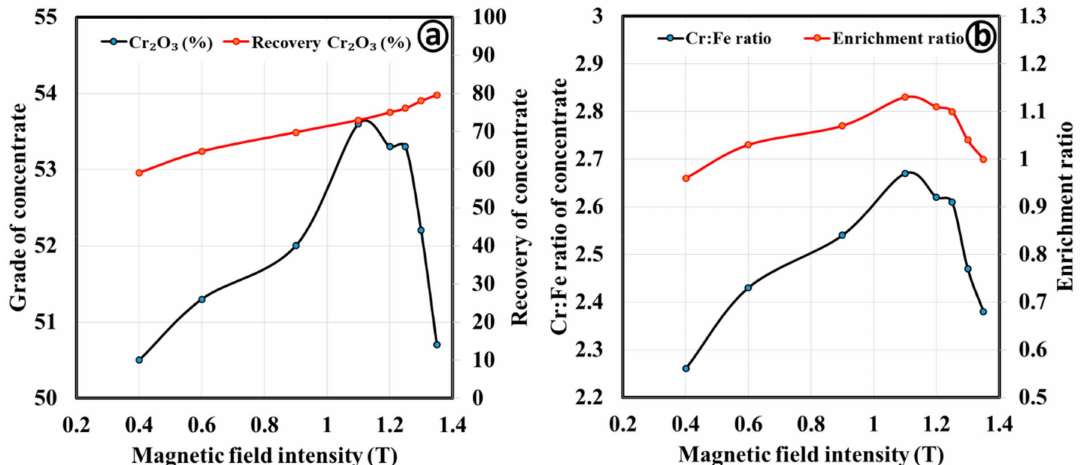
Figure 12. Influence of the magnetic field intensity on the treating coarse concentrate by the WHIMS ( a ) for grade and recovery; ( b ) for Cr:Fe ratio and enrichment ratio of concentrate.